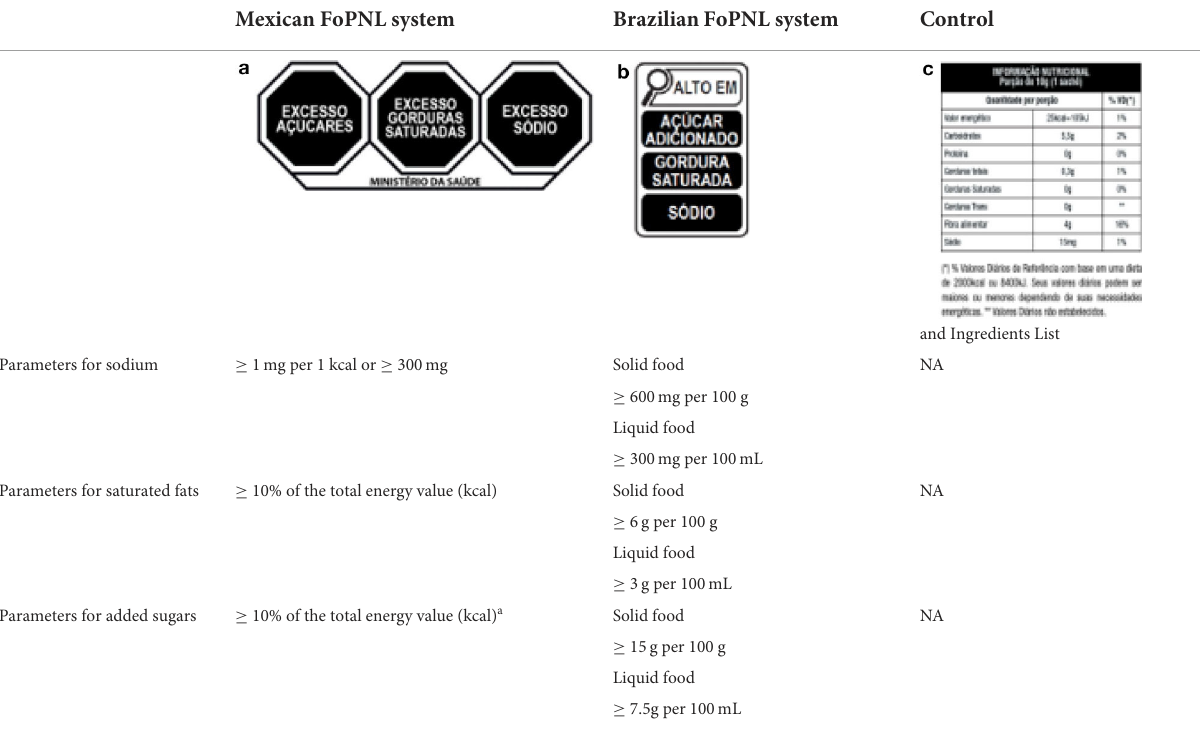
TABLE 1 Different front-of-pack nutrition labels and control and their respective parameters for categorizing excess added sugars, saturated fats, and